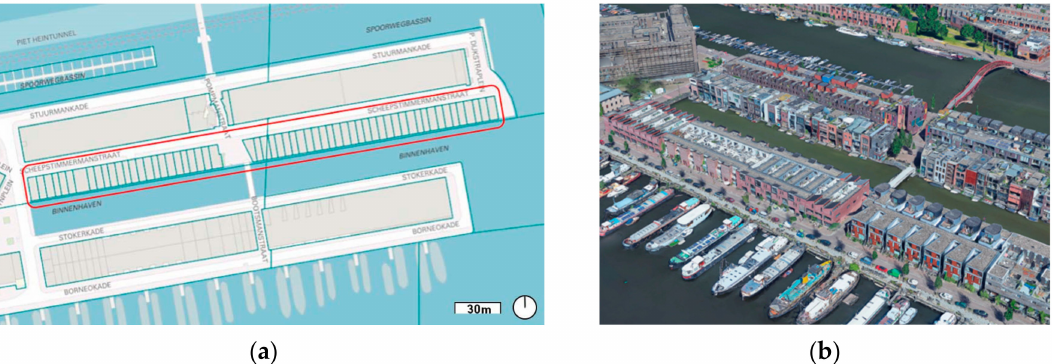
Figure 7. Overview of case study 1: ( a ) cadastral map with location of the lot [30].; ( b ) aerial view of the building complex